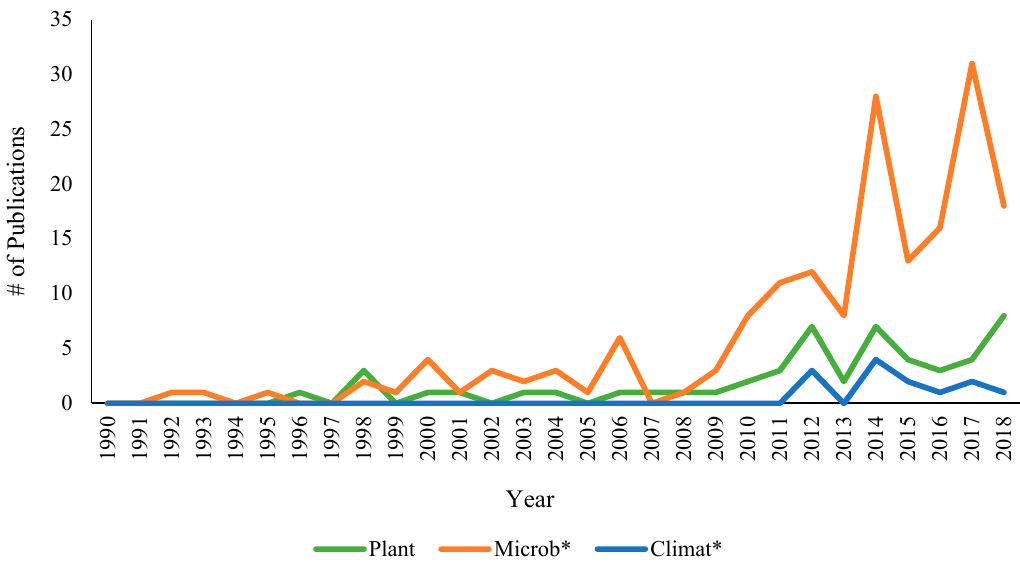
Figure 4. Nitrous oxide reductase-related publications released since 1990 on Web of Science (Clarivate Analytics). Publications by key word vs “nitrous oxide reductase” from 1990 to 2018. The orange line indicates “nitrous oxide reductase” + “microb*”; green: “nitrous oxide reductase” + “plant”; blue: “nitrous oxide reductase” + “climat*”.